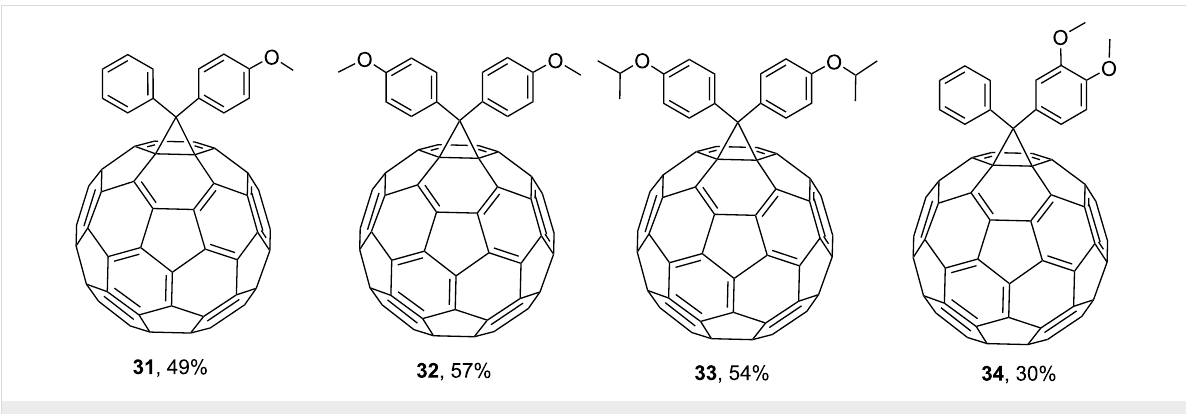
Figure 3: Structures of diphenyldiazomethanes 31 – 34 .